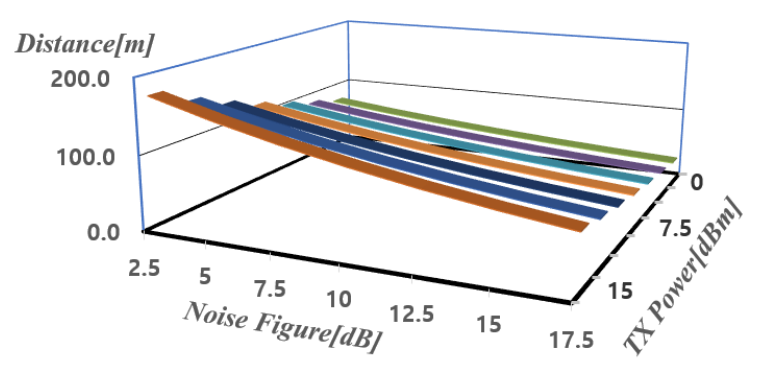
Figure 2. Calculation of maximum detection distance for FMCW radars.